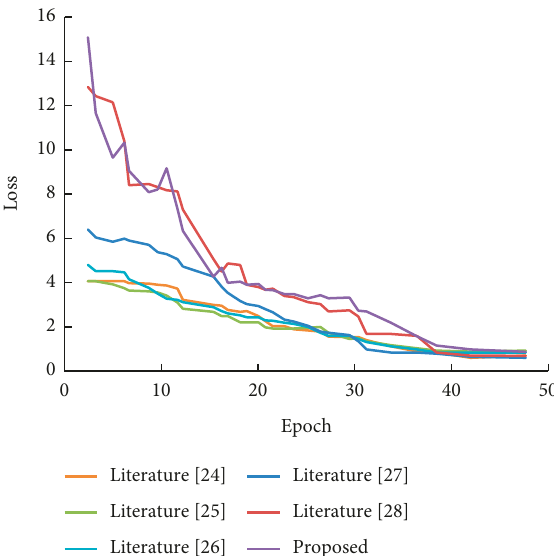
Figure 8: NTU-RGB +D 120 data set training result graph: loss.